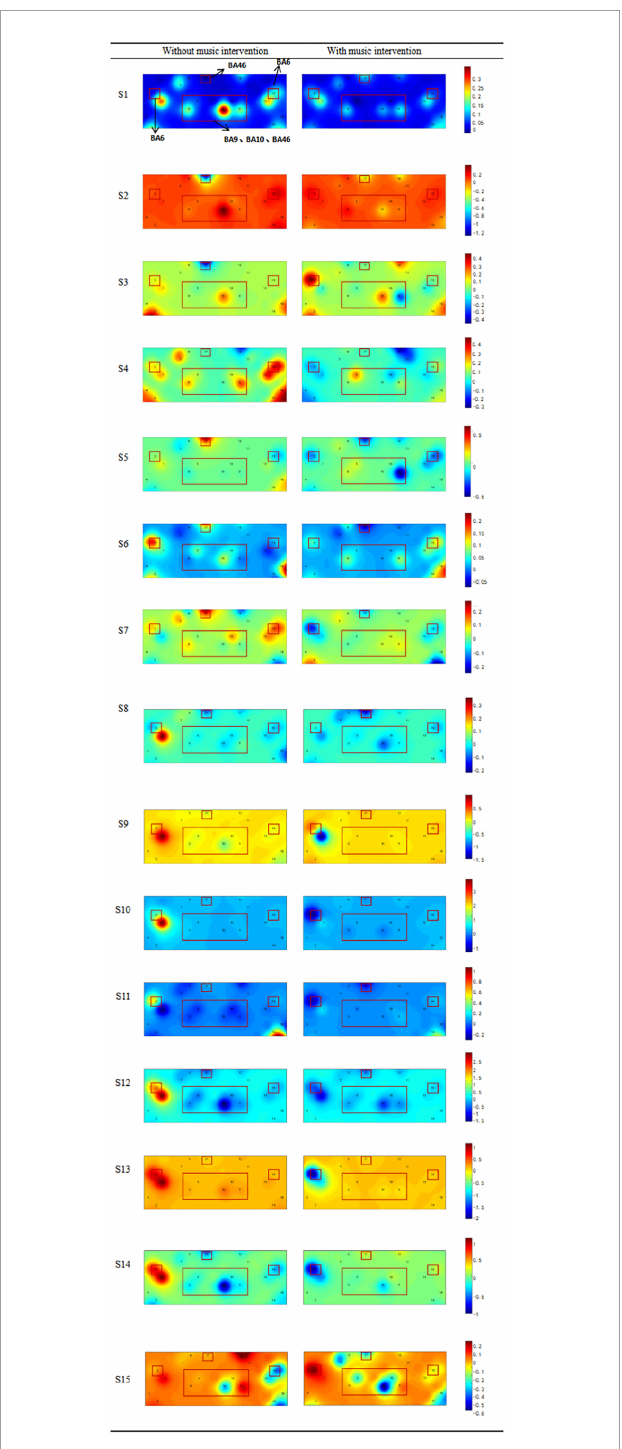
FIGURE4 Comparison of activation levels in the prefrontal cortex (BA9, BA10, BA46) and motor area (BA6) with or without music intervention. The color from blue to red indicates a continuous increase in brain activation. The regions of interest (ROI) brain regions mentioned above that are associated with pain have been framed, including the prefrontal cortex and motor